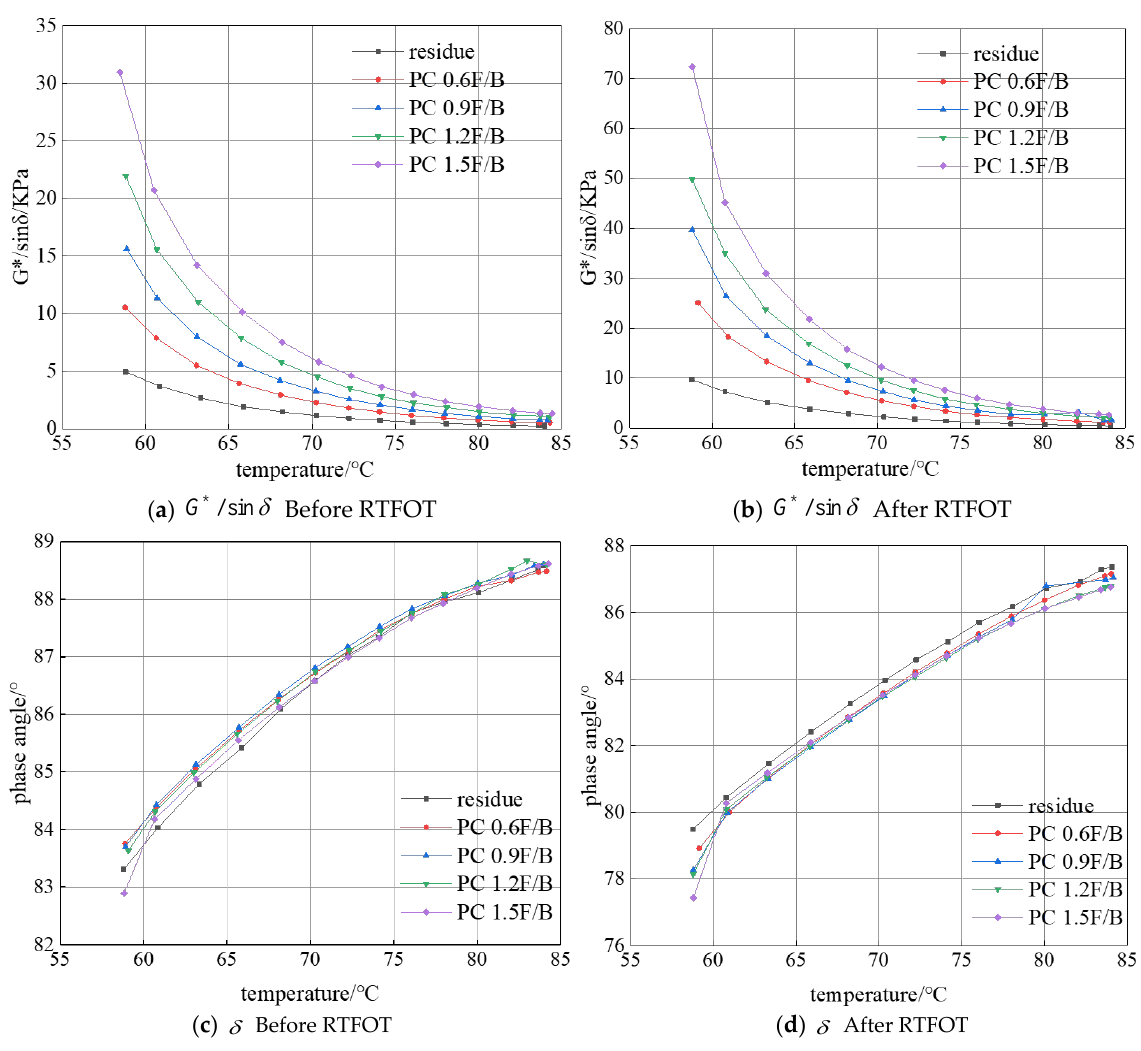
Figure 5. Temperature scanning test results of cement asphalt mastics.